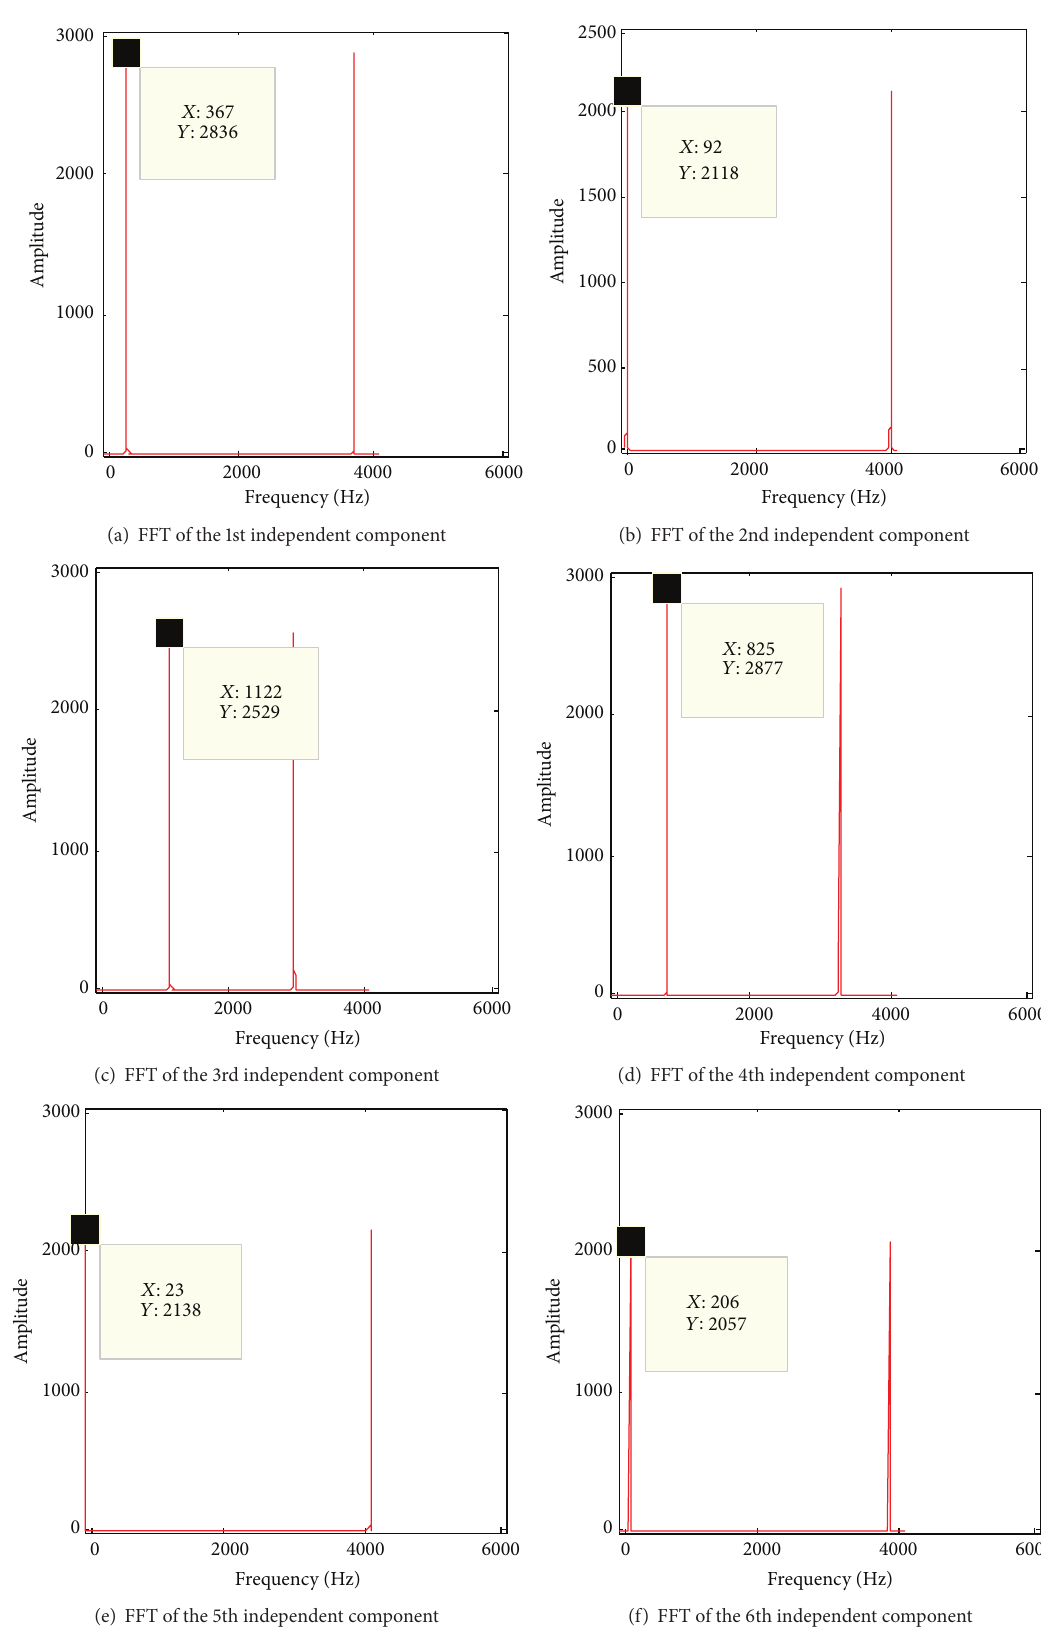
Figure 3: FFT of each independent component identified by maximization kurtosis with gradient descent